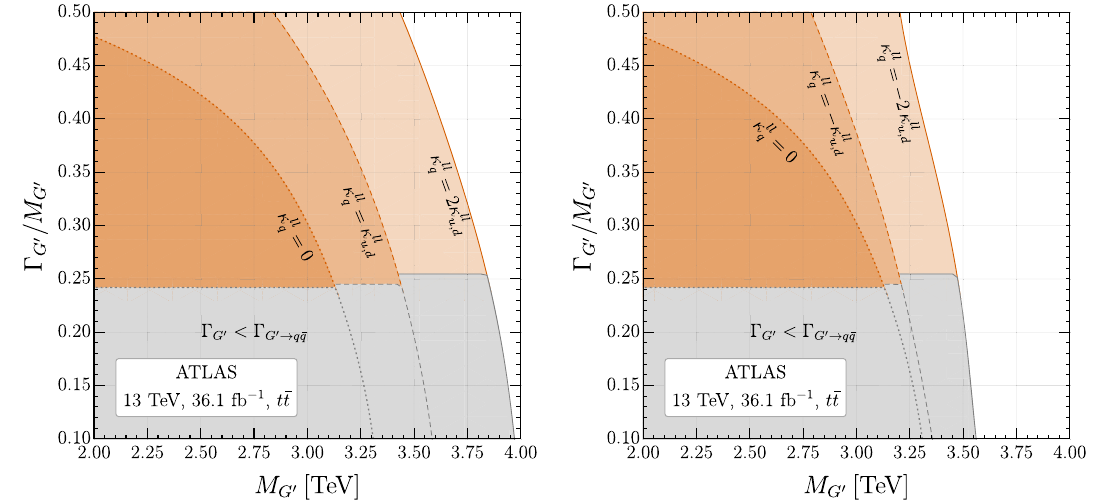
Fig. 10 Exclusion limits on the coloron for the pp → t ¯ t search in the ((cid:16) G (cid:2) / M G (cid:2) , M G (cid:2) ) plane for different choices of the couplings to light left-handed